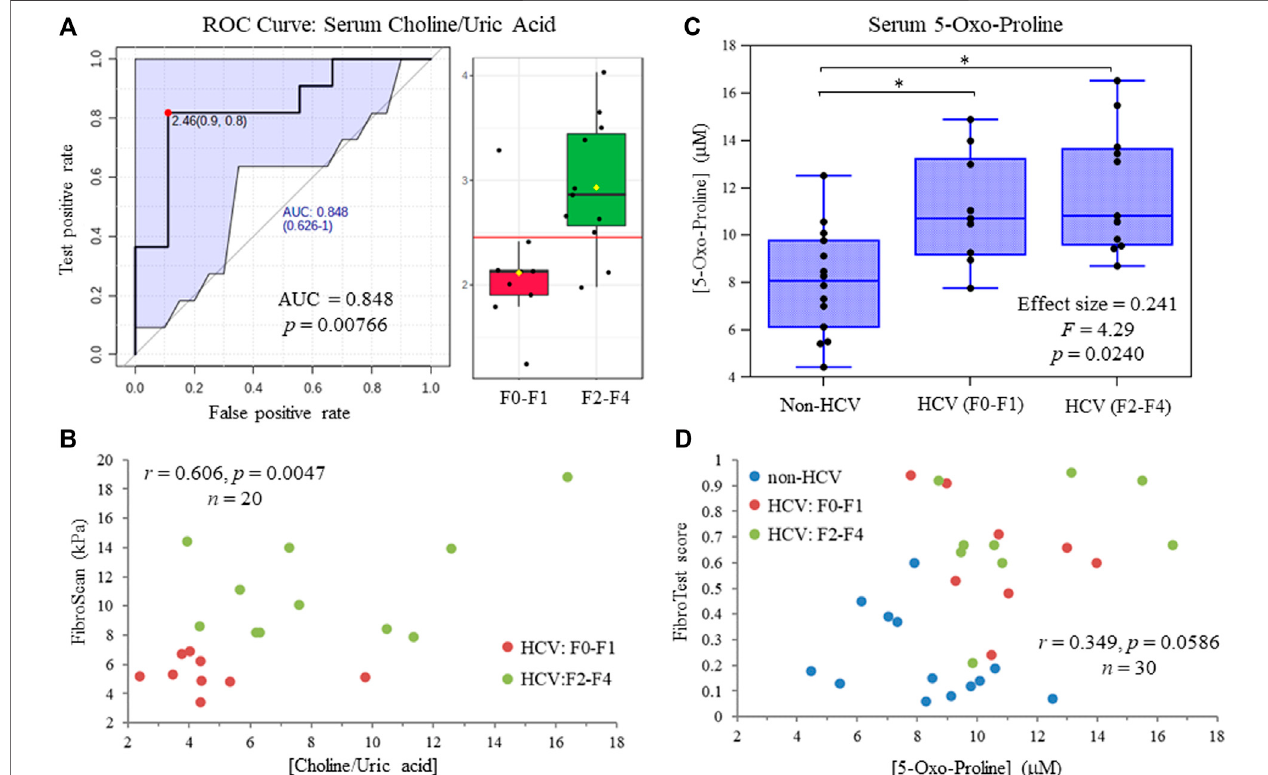
FIGURE 5 | (A) Receiver operating characteristic (ROC) curve highlighting that serum choline:uric acid ratio optimally differentiates late (F2-F4) from early (F0-F1) stageliver fi brosisintreatmentnaïveHCVpatientswithanareaunderthecurve,AUC (cid:1) 0.848. (B) Amoderatepositivecorrelationisshownbetweentheserumcholineto uricacidratioandindependentFibroScanresultsfromultrasoundimagingofHCVpatientsatdifferentstagesofliver fi brosis. (C) ANCOVA(between-subjecteffects)with covariate adjustments con fi rms that serum 5-oxo-proline concentrations are elevated in HCV patients with early and late-stage liver fi brosis as compared to non- HCV controls (* p < 0.05). (D) A weak positive correlation is depicted for serum 5-oxo-proline concentrations and FibroTest scores from a blood liver protein panel that differentiate non-HCV controls from HCV patients with chronic hepatic in fl